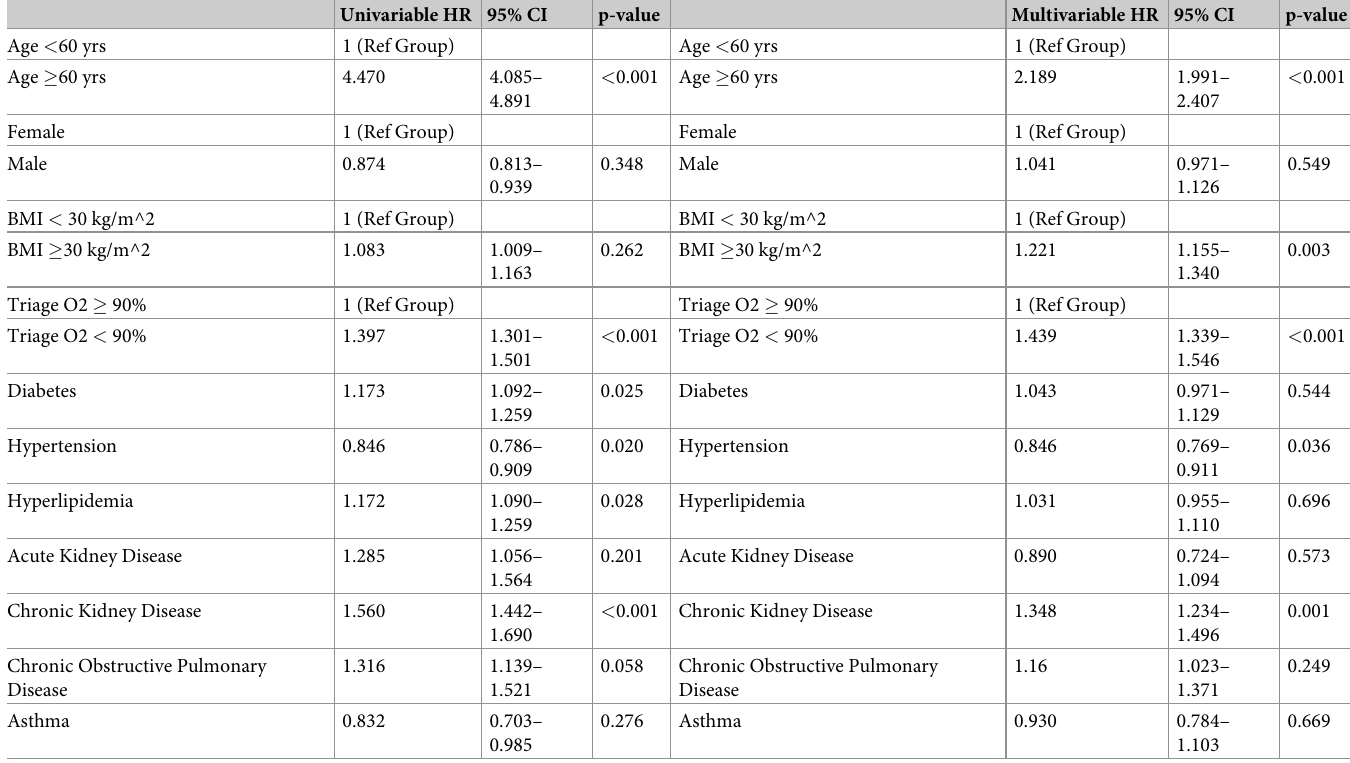
Table 2. Univariable and multivariable Cox proportional hazards model for in-hospital mortality among COVID-19